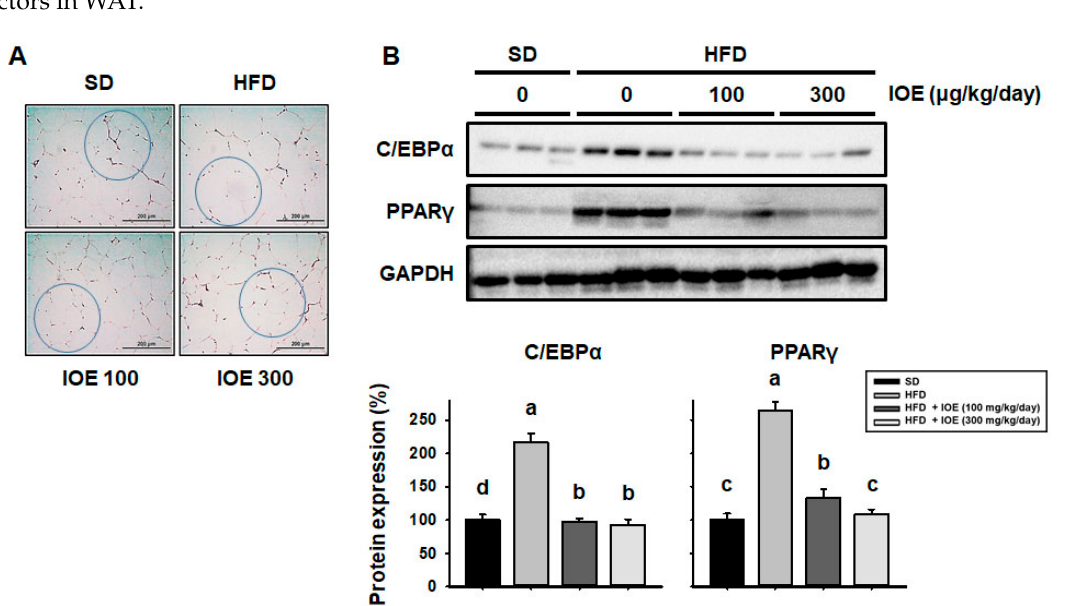
Figure 3. IOE treatment is associated with smaller lipid droplets in WAT and lower expression of key lipogenic transcription factors in the WAT of HFD-induced obese mice. ( A ) WAT morphology was analyzed using hematoxylin and eosin (H&E) staining. ( B ) Western blotting of lipogenic transcription factors (C/EBP α and PPAR γ ) in WAT. Data are expressed as mean ± S.D ( n = 6). Values with different letters are significantly different; p < 0.05 (a > b > c).